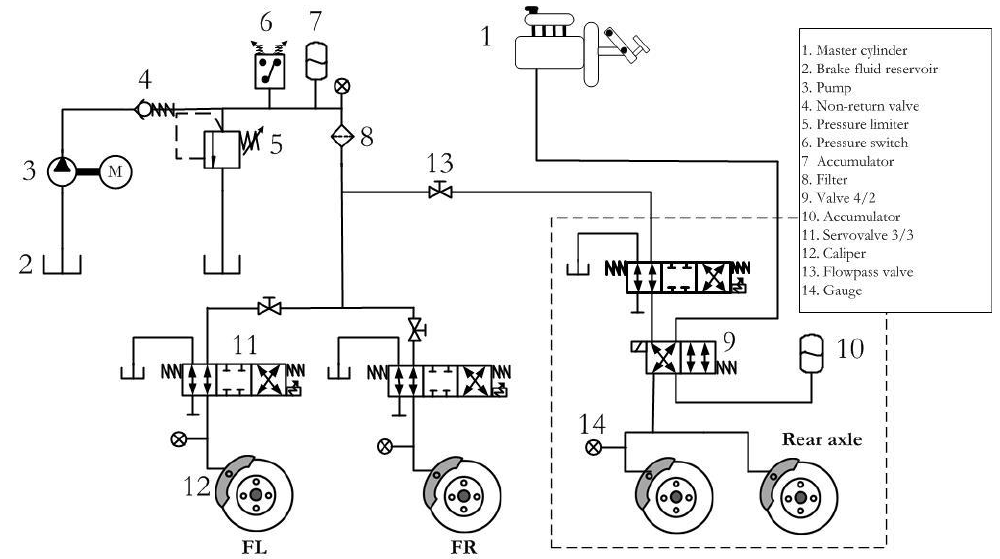
Figure 2. Brake-by-Wire braking system hydraulic diagram.